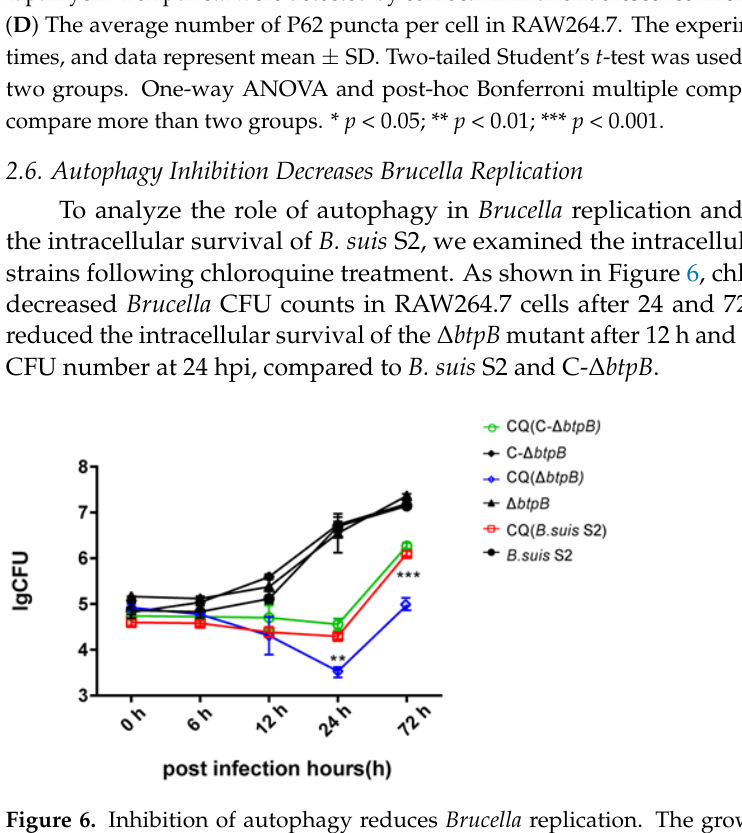
Figure 6. Inhibition of autophagy reduces Brucella replication. The growth of Brucella strains in RAW264.7 cells treated with 10 µ M chloroquine or vehicle. ** p < 0.01, *** p < 0.001 by one-way ANOVA and post-hoc Bonferroni multiple comparison test.